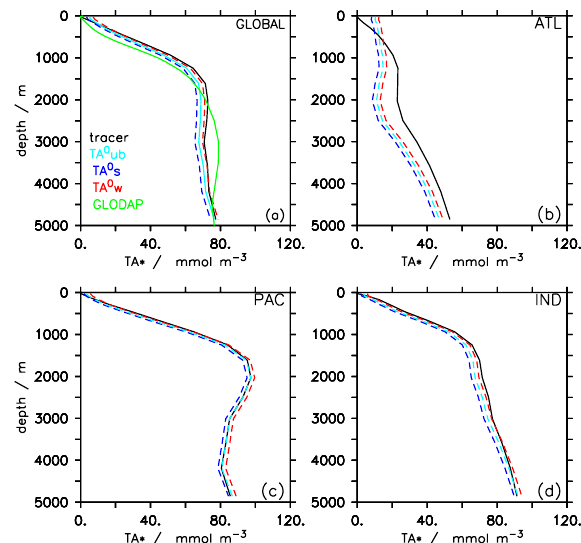
Figure 7. (a) Global mean profile of TA ∗ from explicit model tracer (black, solid) and computed from model data (dashed). The two dashed lines are based on seasonally biased sampling of the model output at the surface when deriving the TA 0 algorithm. TA 0 s refers to sampling during summer, TA 0 w refers to winter sampling when deep water actually forms. TA 0 refers to seasonally unbiased sam- ub pling. For comparison, the green line shows the global mean profile of TA ∗ computed from the GLODAP database and using a globally uniform algorithm derived from the gridded surface GLODAP data (b–d) . Basin-averaged profiles of TA ∗ for the Atlantic, Pacific and Indian oceans. Tracer-based estimate (black, solid) and computed TA ∗ from winter- and summer-biased TA 0 algorithms are